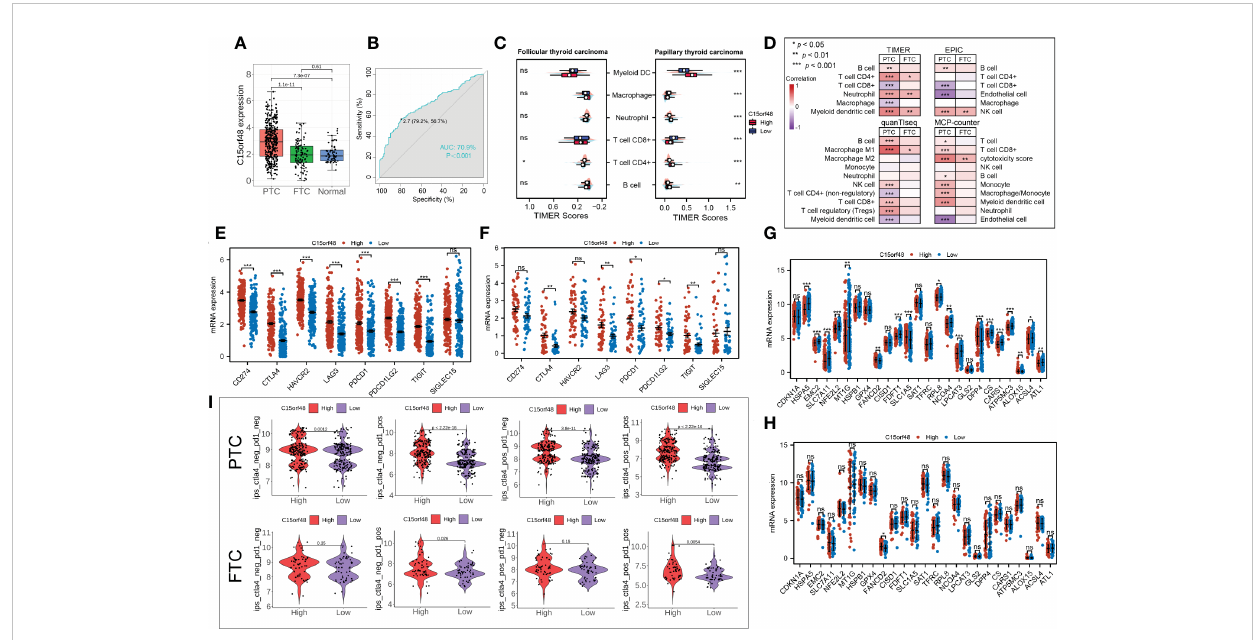
FIGURE 7 (A) Expression levels of C15orf48 in THCA subtypes; (B) ROC curves reveal high expression speci fi city of C15orf48 in PTC subtypes; (C) The immune scoring results of different subtypes of THCA (TIMER); (D) Correlation between C15orf48 and immune cell in fi ltration in different THCA isoforms; (E) Correlation between C15orf48 and immune checkpoints in PTC subtypes; (F) Correlation between C15orf48 and immune checkpoints in FTC subtypes; (G) Correlation between C15orf48 and ferroptosis-related genes in PTC subtypes; (H) Correlation between C15orf48 and ferroptosis- related genes in FTC subtypes; (I) Immunotherapy response results of two subtypes of THCA. *P < 0.05; **P < 0.01; ***P < 0.001, ns, no signi fi